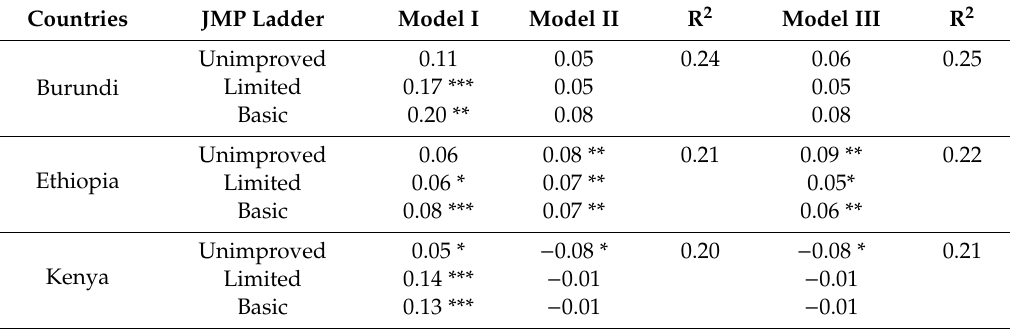
Table 5. Predicted increments in young child LAZ (6–23 mo) associated with JMP sanitation indicators in East